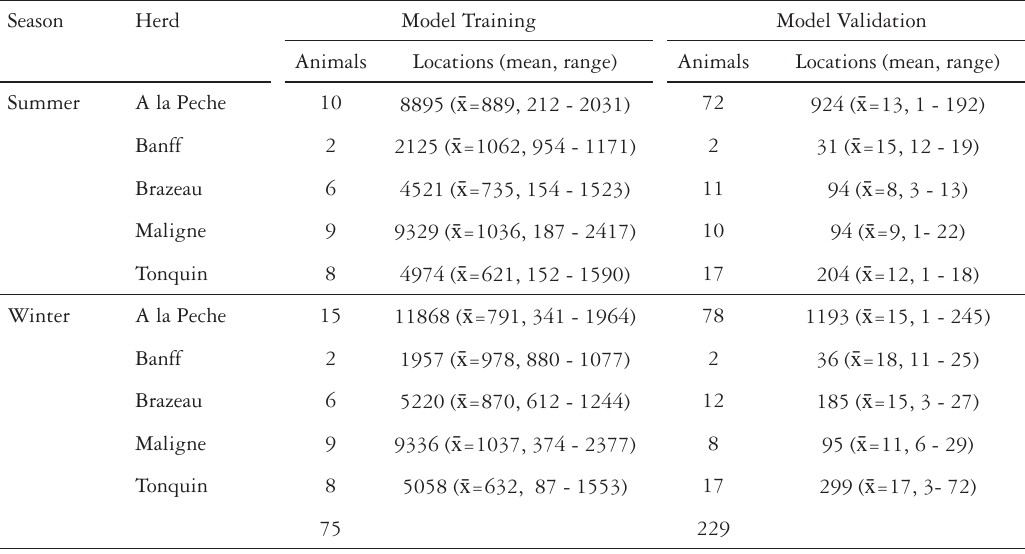
S-table 1. Number of radiocollared caribou monitored in Banff and Jasper National Parks, and total number of locations used in model development and validation.